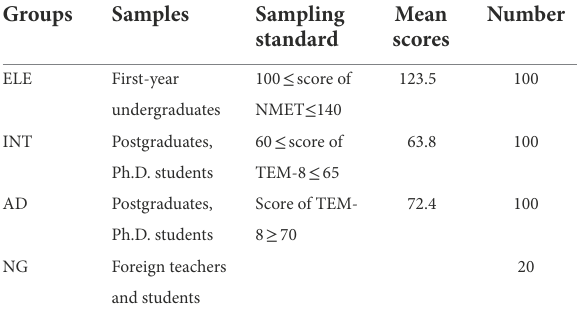
TABLE 1 Information of each